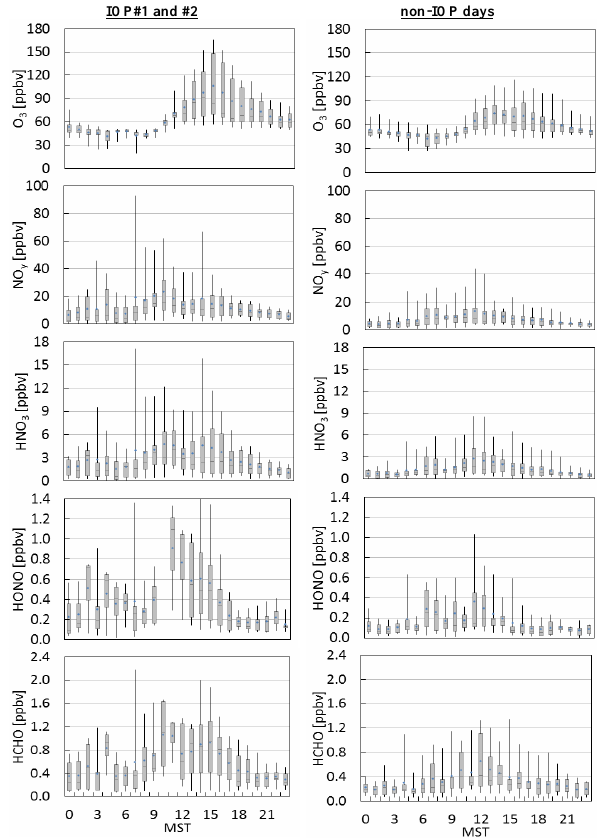
Figure 3b. Mean diurnal variation of selected trace gases for IOP and non-IOP